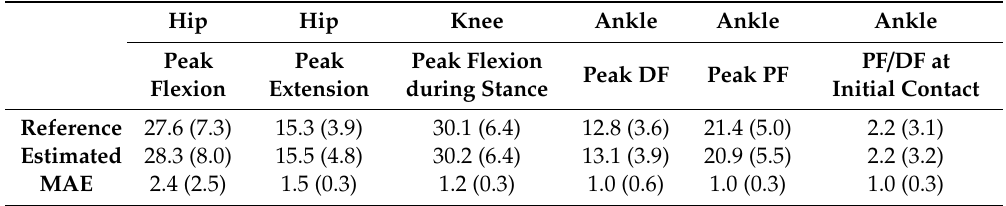
Table 3. Estimated and reference joint angles (SD) at discrete gait events in the intra-participant model.